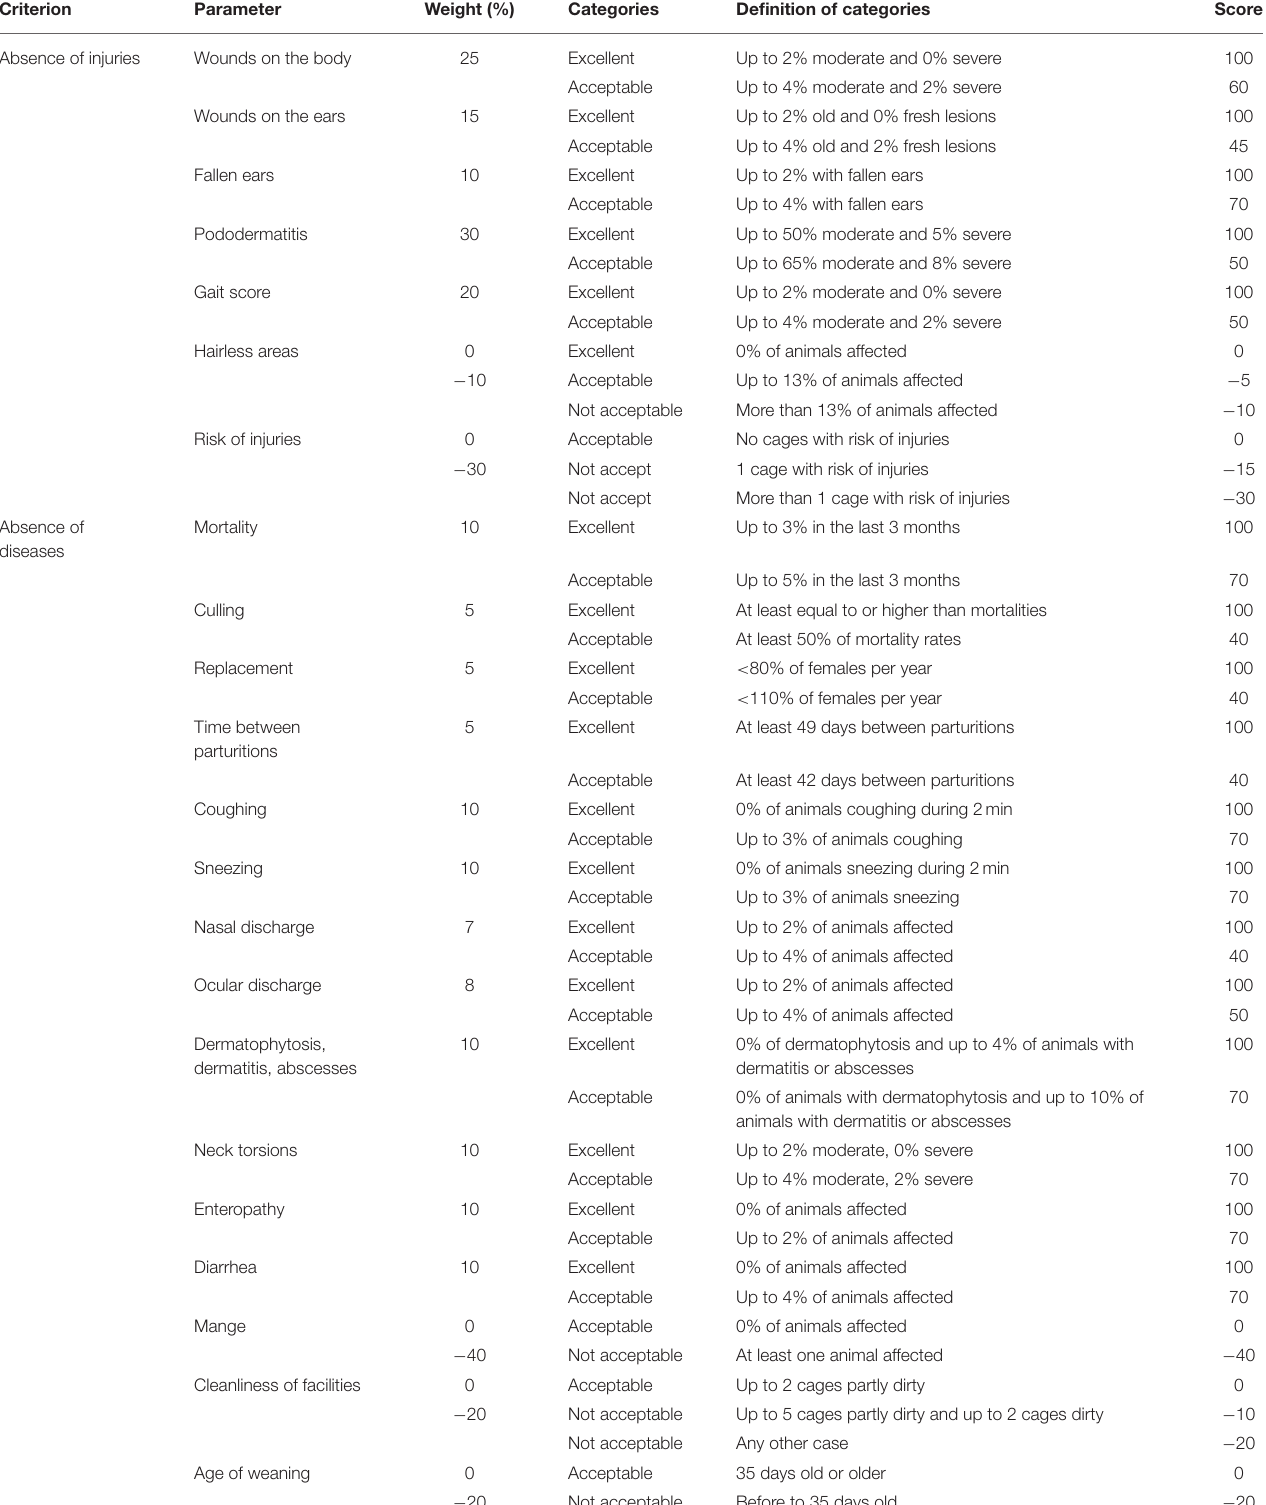
TABLE 4 | Parameters used to assess the criteria of absence of injuries, absence of diseases, and pain induced by management procedures.